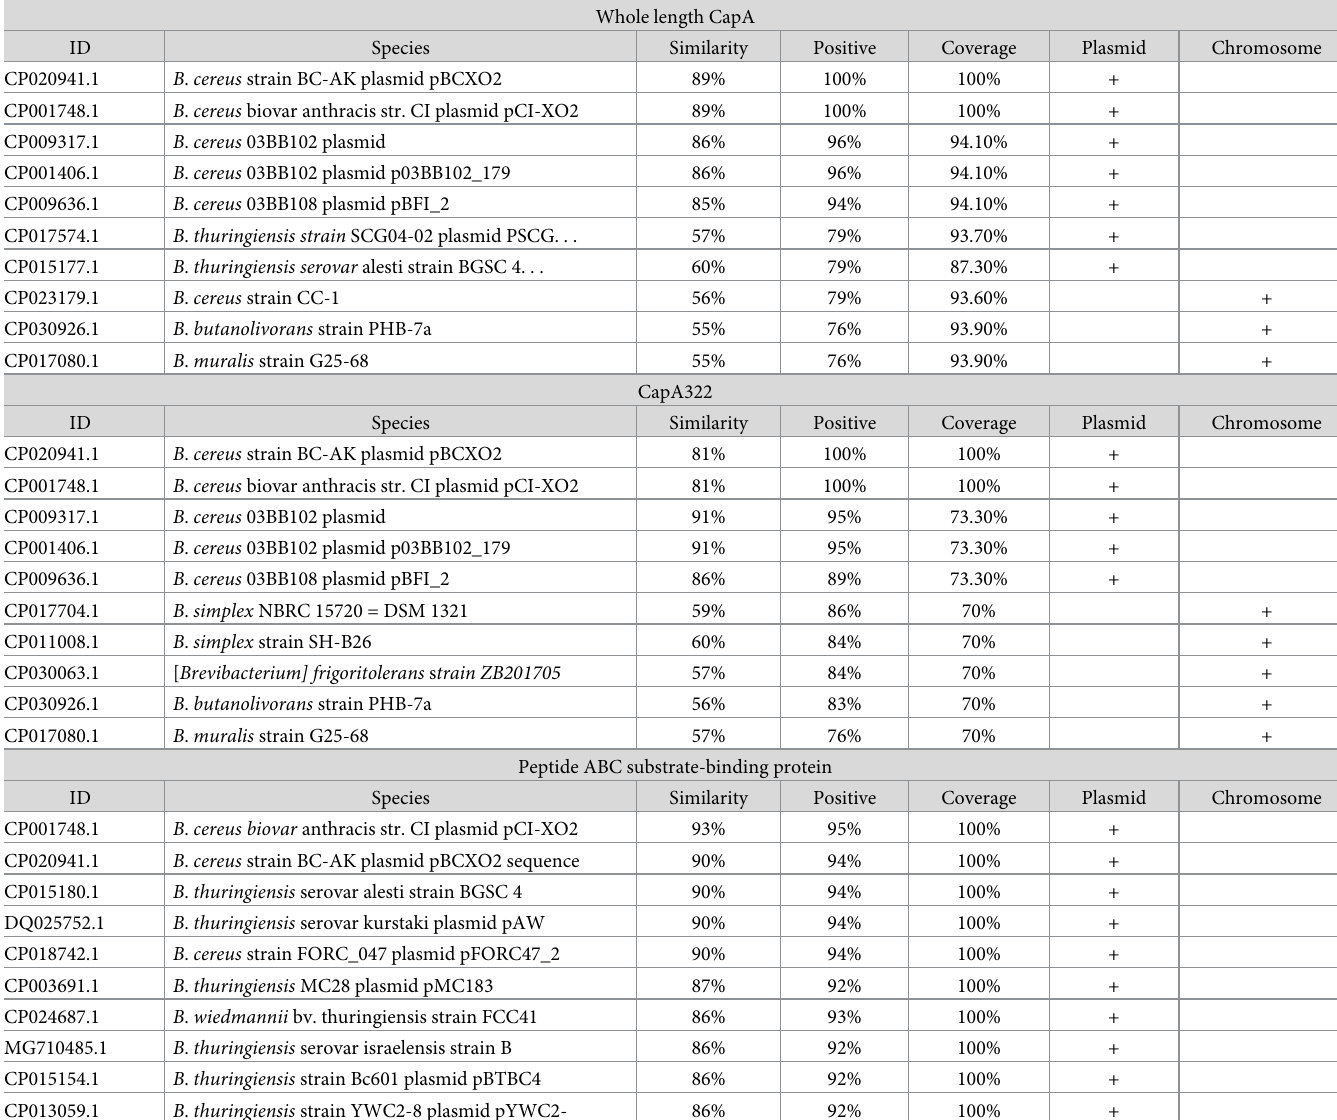
Table 4. Sequence similarity of two immunoreactive proteins identified by Western blotting with horse hyperimmune antisera and